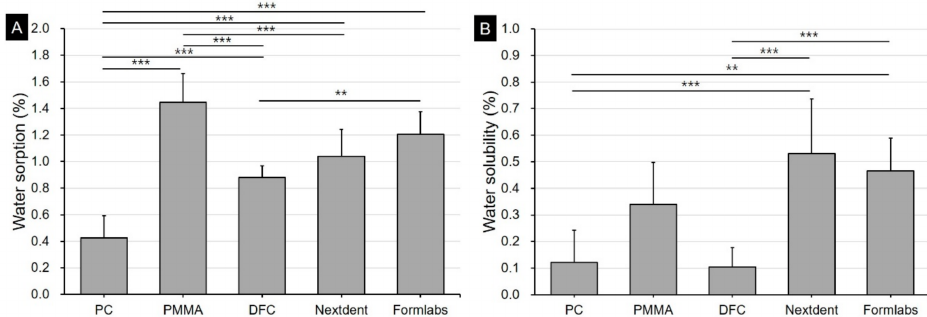
Figure 4. Graphs showing the di ff erences in changes of water sorption and solubility according to the type of restorative materials (mean + standard deviation). ( A ) Water sorption, ( B ) Solubility. In each graph, the double (**) asterisk represents a p -value ≤ 0.01 and the triple (***) asterisk represents a p -value ≤ 0.001.